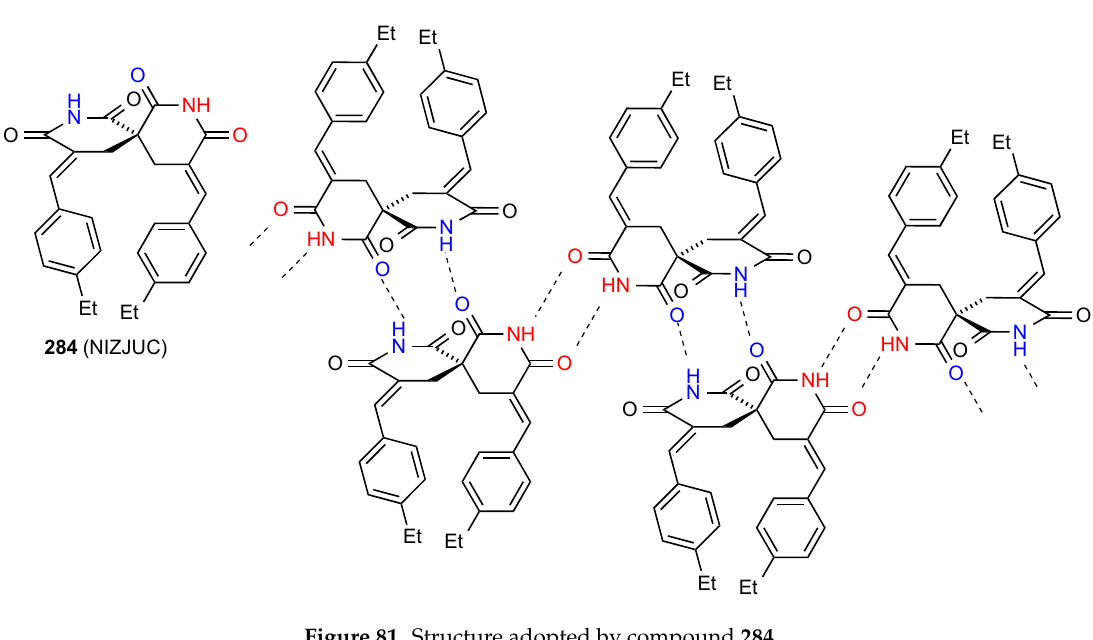
Figure 81. Structure adopted by compound 284.